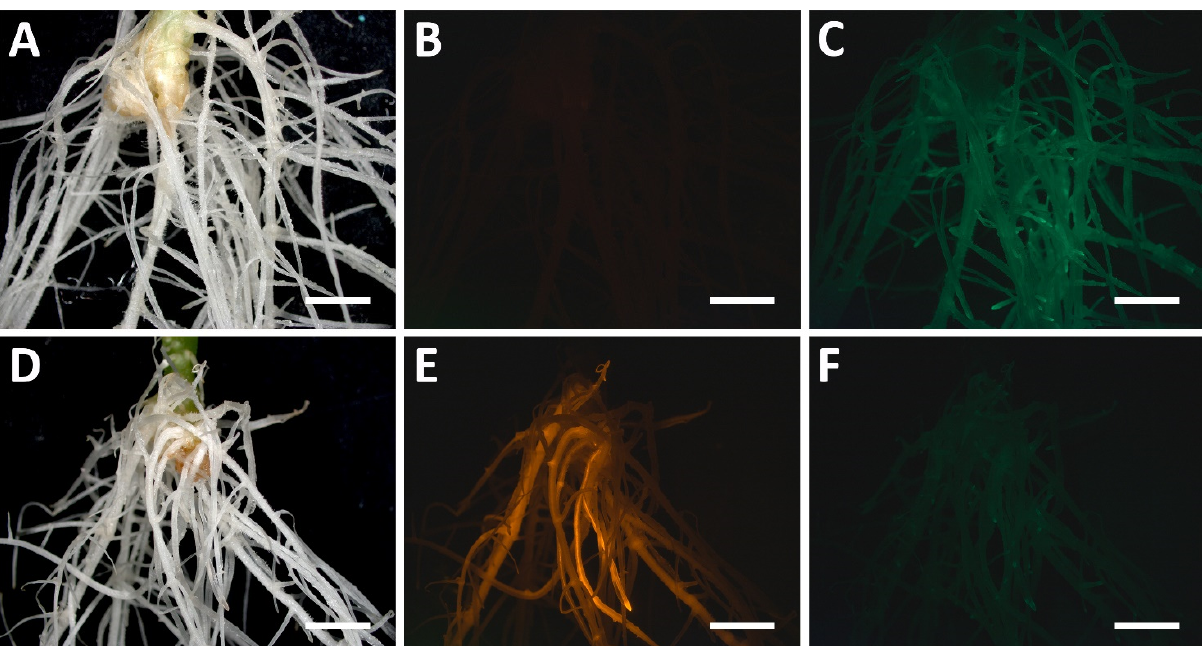
Figure 6. Cucumber ( Cucumis sativus ) hairy roots co-transformed with pKSEe401R with a DsRed1 cassette in tandem (A–C) or reverse (D–F) orientation relative to the Cas9 cassette. (B) DsRed1 fluorescence was absent when the fluorescent protein (FP) cassette was in tandem orientation relative to the Cas9 cassette; (E) DsRed1 fluorescence was visible when the FP cassette was in reverse orientation relative to the Cas9 cassette. (A,D) bright field illumination; (C,F) root autofluorescence. Scale bars denote 5 mm.